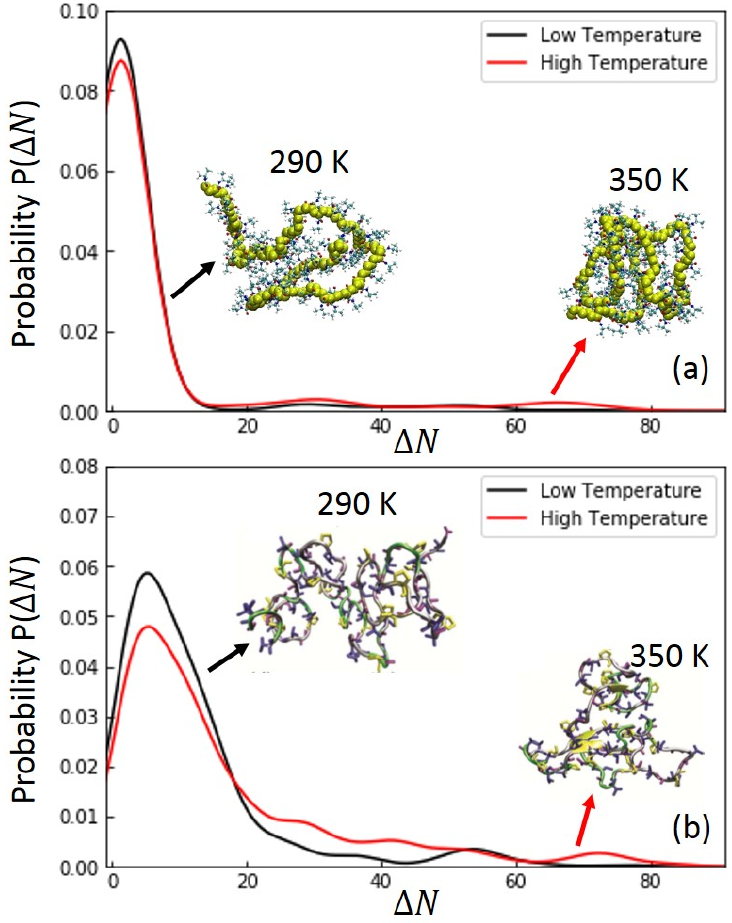
Figure 8. Hydrogen bonding time (HBT) probability distribution as function of residue distance ( ∆ N) for ( a ) 90-mer PNIPAM and ( b ) 90-mer ELPs, respectively for temperatures below LCST (black curve) and above LCST (red curve). For ELP, the high temperature curve is averaged for simulations at temperatures above 325 K. For 90-mer PNIPAM, the high temperature curve is averaged for simulations at temperatures above 310 K. Final simulation snapshots of 90-mer PNIPAM and ELP are shown for ~290 K and ~350 K.